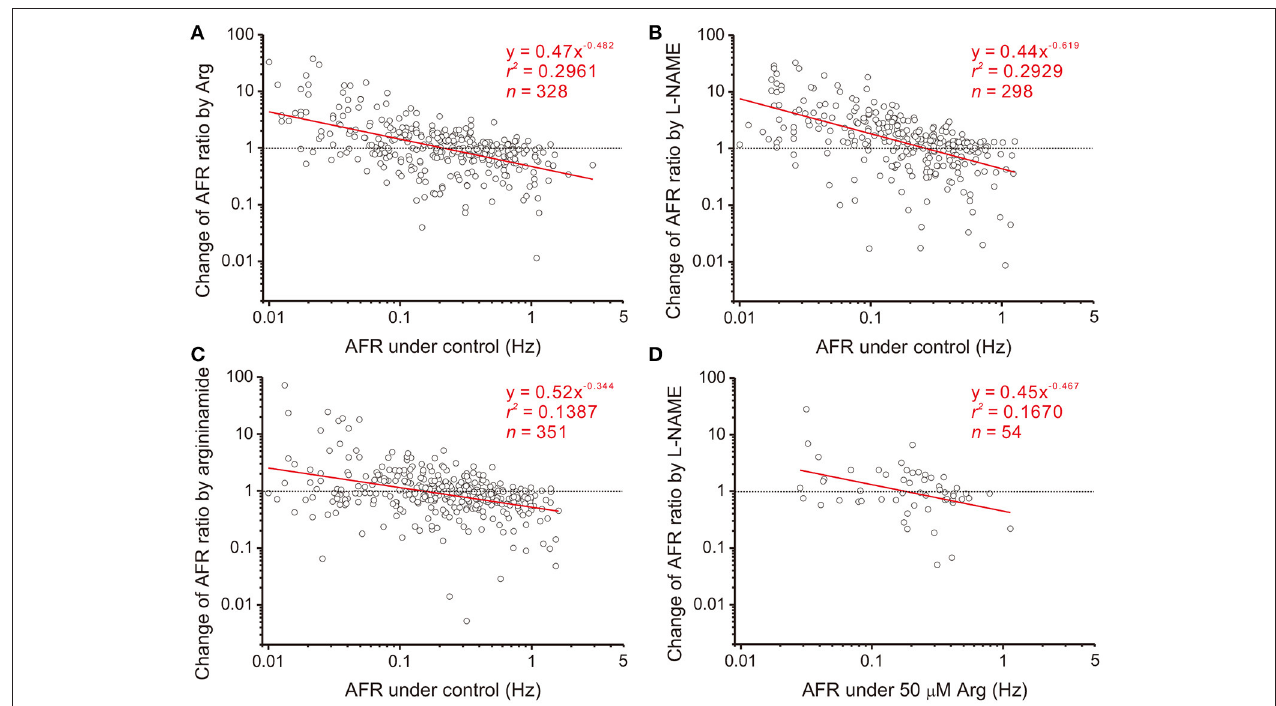
FIGURE 3 | Heterogeneity in NO-mediated changes of firing activities is a power function of their basal activities. Each circle in the plots represents a drug-induced single-fiber response. AFR ratios, y, are the AFR after drug applications divided by the AFR prior to drug applications (i.e., x). Data were obtained from applications of